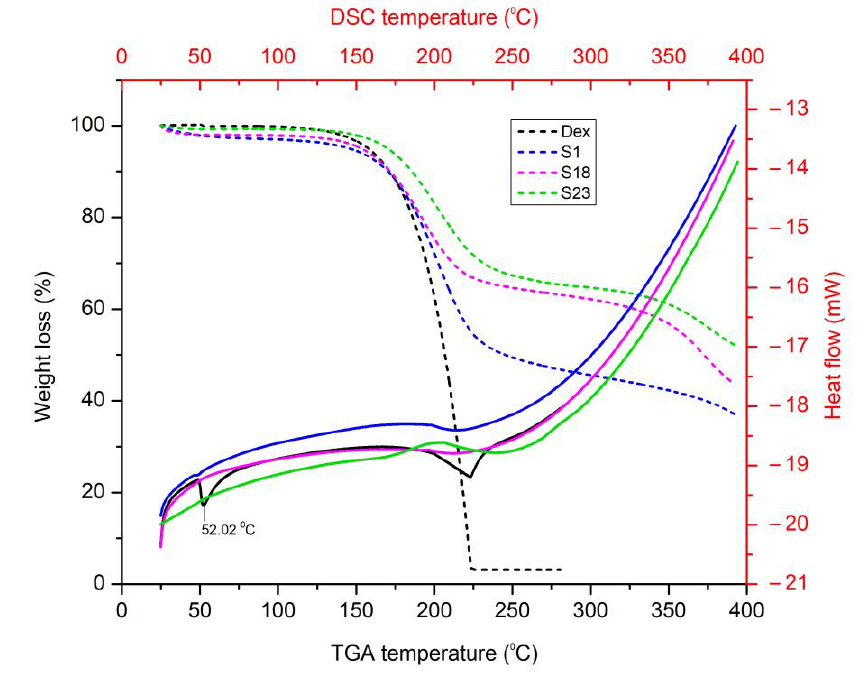
Figure 5. TGA and DSC graphs of Dex, S1, S18, and S23.